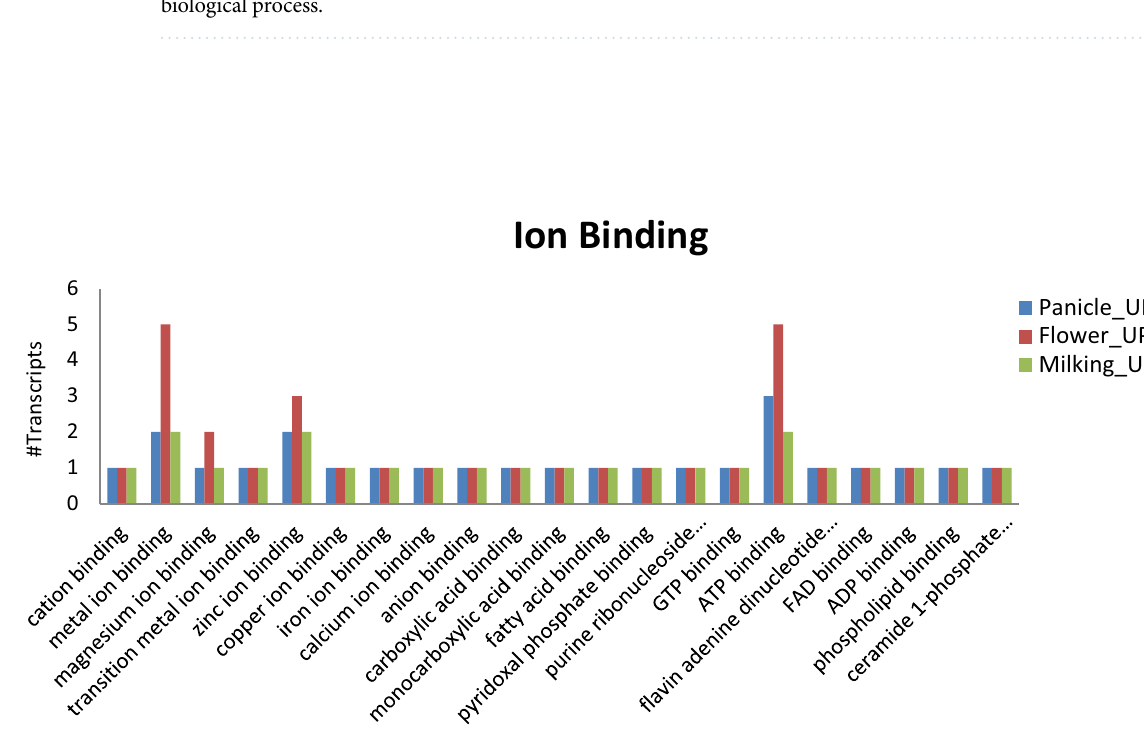
Figure 2 . GO enrichment analysis of DEGs was classified into ( A ) up-regulated cellular components, molecular function and biological process; ( B ) down-regulated cellular components, molecular function and biological process.